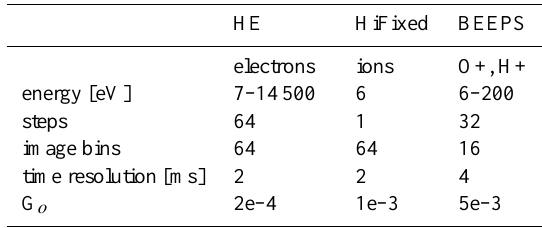
Table 1. SIERRA particle instrumentation